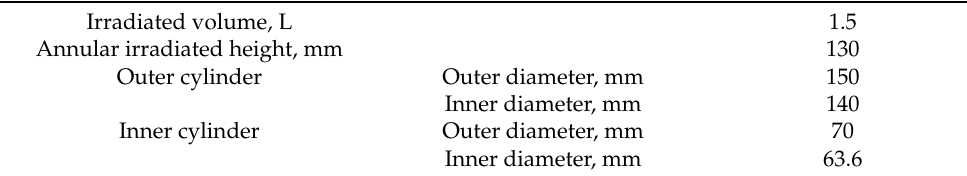
Table 1. Photoreactor specifications. Irradiated volume, L 1.5 Annular irradiated height, mm Outer